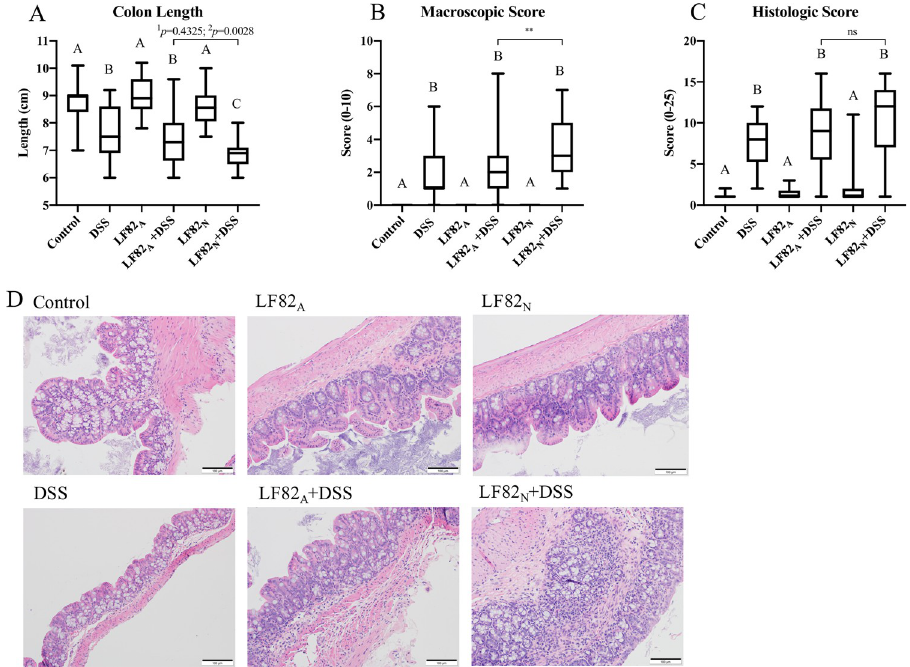
Fig 2. E . coli LF82 N mice develop severe, transmural colitis following DSS-induced inflammation. Mice were scored at the time of necropsy for macroscopic parameters of disease including colon length ( A ) and macroscopic colitis score (as described in Materials and Methods) ( B ). Additionally, proximal colon was blindly scored for histopathologic parameters of inflammation by a pathologist (JH) ( C ). Representative photomicrographs of histopathological sections imaged at 40X (scale bar = 100 μ m) ( D ). Shared letters between different groups indicate no statistical significance with an ANOVA or Kruskal-Wallis with multiple group comparisons test. Asterisk indicate statistical significance based on a direct comparison with a Mann-Whitney two-tailed test, � p � 0.05, �� p � 0.01. p for colon length data indicates significance based on a linear regression model for 1 all groups and between the 2 DSS treated groups. A and B: Control n = 17, DSS n = 21, LF82 A n = 21, LF82 A + DSS n = 28, LF82 N n = 24, LF82 N + DSS n = 32; C: Control n = 13, DSS n = 12, LF82 A n = 16, LF82 A + DSS n = 24, LF82 N n = 19, LF82 N + DSS n = 29.